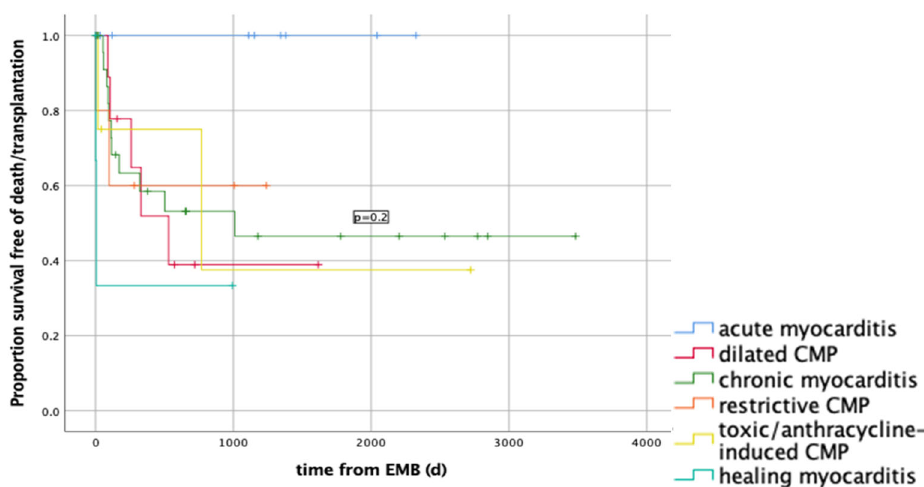
Figure 1. Survival function in relation to the most frequent histological findings ( p = 0.2). Death/transplantation occurred in 0/9 (0%) patients with acute myocarditis; 5/10 (50%) with a dilated CMP; 11/25 (44%) with a chronic myocarditis; 2/3 (60%) with a restrictive CMP; 2/4 (50%) with a toxic/anthracycline-induced CMP; 2/4 (50%) with a healing myocarditis (50%).